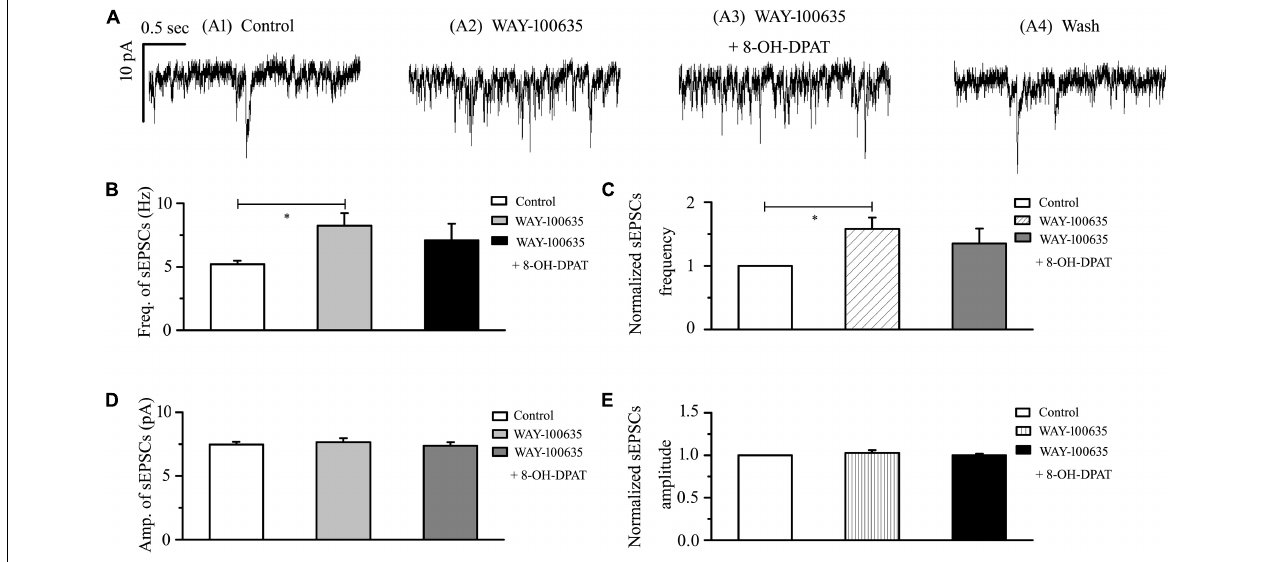
FIGURE 5 | WAY-100635 prevented the inhibitory effects of 8-OH-DPAT on sEPSCs in OFF-type RGCs. (A) Representative recordings during control conditions (A1) , during WAY-100635 (10 µ M) application (A2) , during WAY-100635 (10 µ M) + 8-OH-DPAT (10 µ M) application (A3) and during recovery (A4) . Vertical scale bar: 10 pA; horizontal scale bar: 0.5 s. After preincubation with WAY-100635 (10 µ M), 8-OH-DPAT (10 µ M) did not significantly change either the frequency (B) or amplitude (D) of EPSCs in RGCs ( n = 8). (C,E) Normalized glutamatergic sEPSC frequency ( n = 8) and amplitude. Note that WAY-100635 increased the baseline frequency (B,C) of the sEPSCs. ∗ p < 0.05, ANOVA.